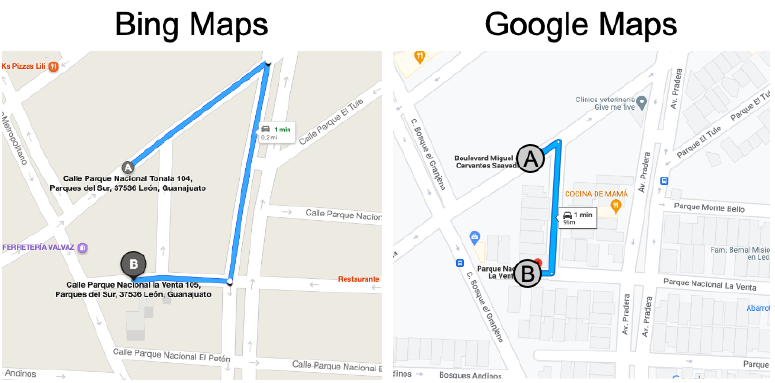
Figure 25. Discrepancy in route